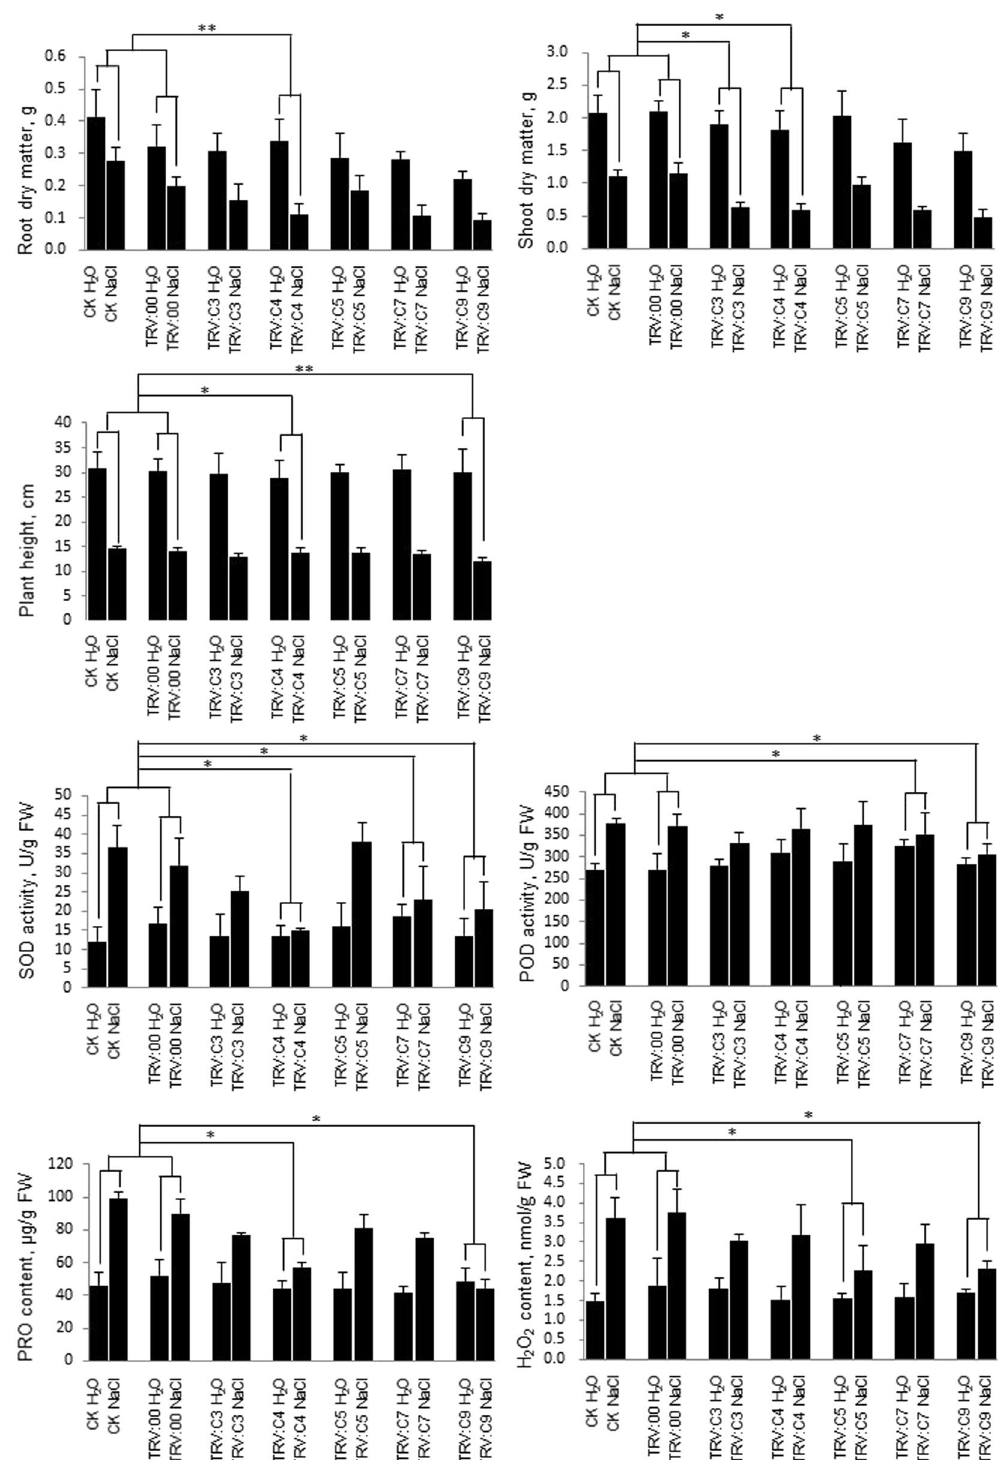
Figure 6. The difference of salt-tolerance parameters between gene-silenced and control plants in response to salt stress. Seven salt-tolerance parameters, including the plant height (cm), shoot dry matter weight (g), root dry matter weight (g), and SOD and POD (U/g FW) activity, and Pro ( μ g/g FW) and H 2 O 2 (nmol/g FW) content were measured in leaves of gene-silenced and control plants with salt stress and water treatment. Plants were treated with 200 mM NaCl for a month (with water treatment as control). Significance level was compared between the difference between salt stress treatment and water control of target gene-silenced plants (TRV: target-silenced gene NaCl, and TRV: target-silenced gene H 2 O), and the difference between salt stress treatment and water control of no-infiltration plants (CK NaCl and CK H 2 O). “ * ”: at P < 0.05; “ ** ”: at P <